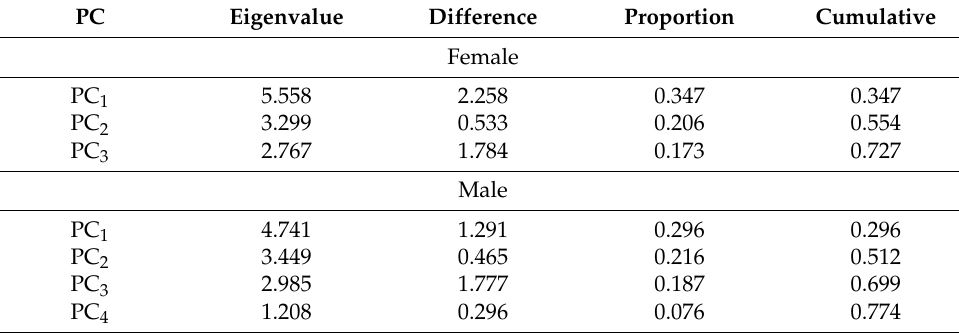
Table 5. PCA and the total of variance explained (female vs. male).